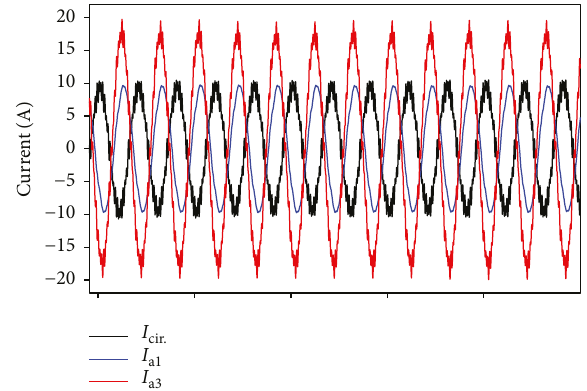
Figure 25: Circulating current with three-winding coupled inductors with a magnetizing inductance of 0.5 mH.